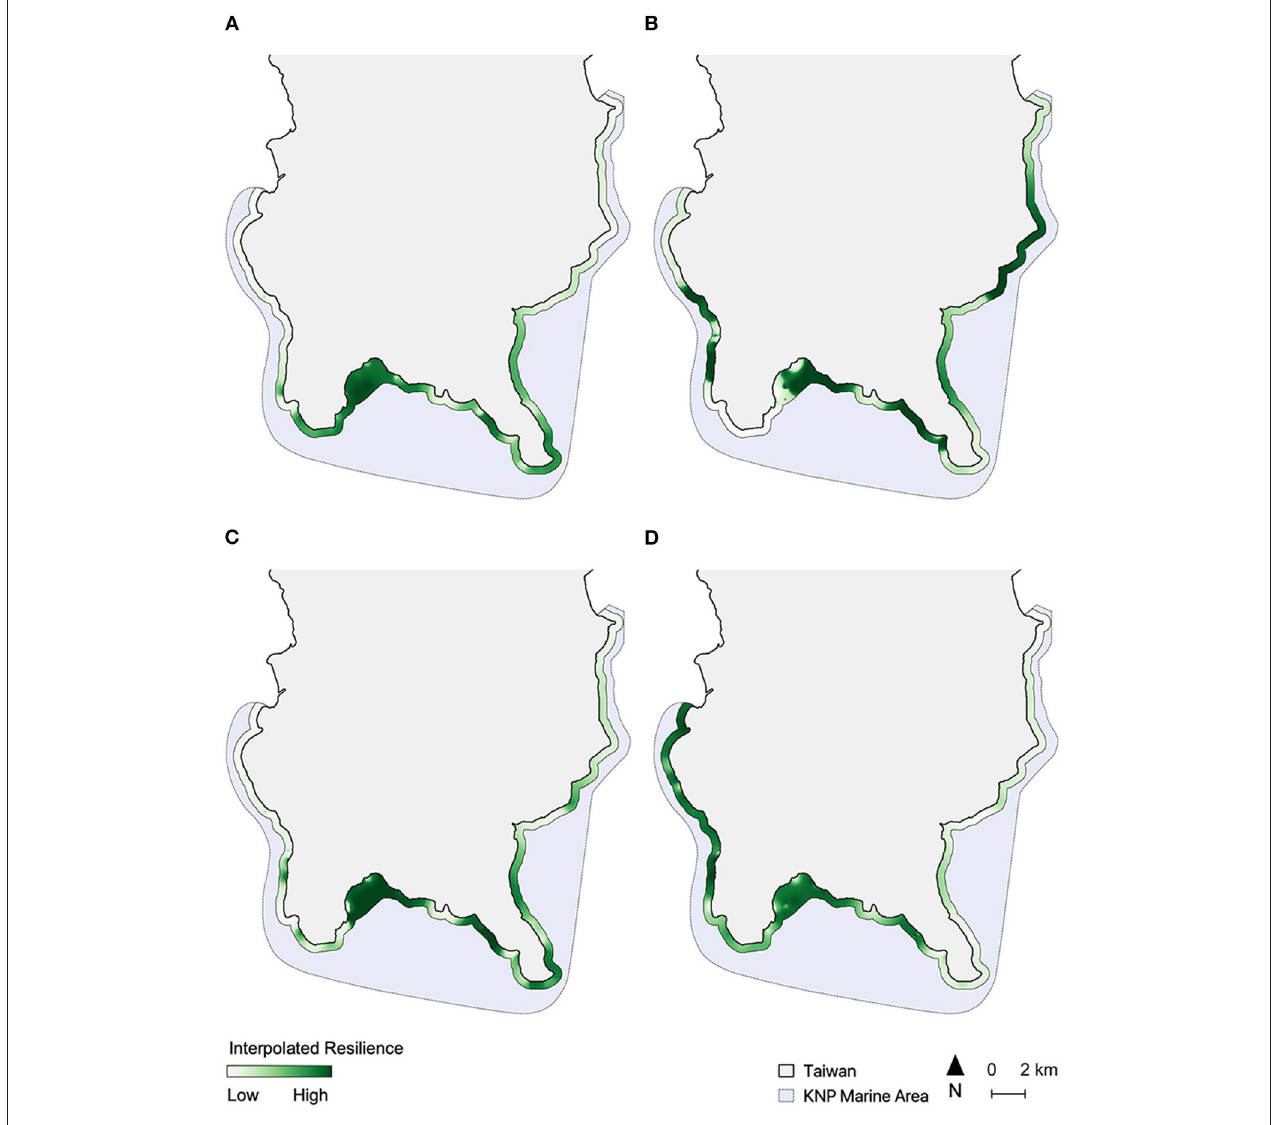
FIGURE 2 | Spatial interpolation of relative resilience scores along a 500-m coastal buffer from each of the four assessments, including (A) Assessment 1; (B) Assessment 2; (C) Assessment 3, and (D) Assessment 4. Resilience score scales are relative for each map and colored on a quantile